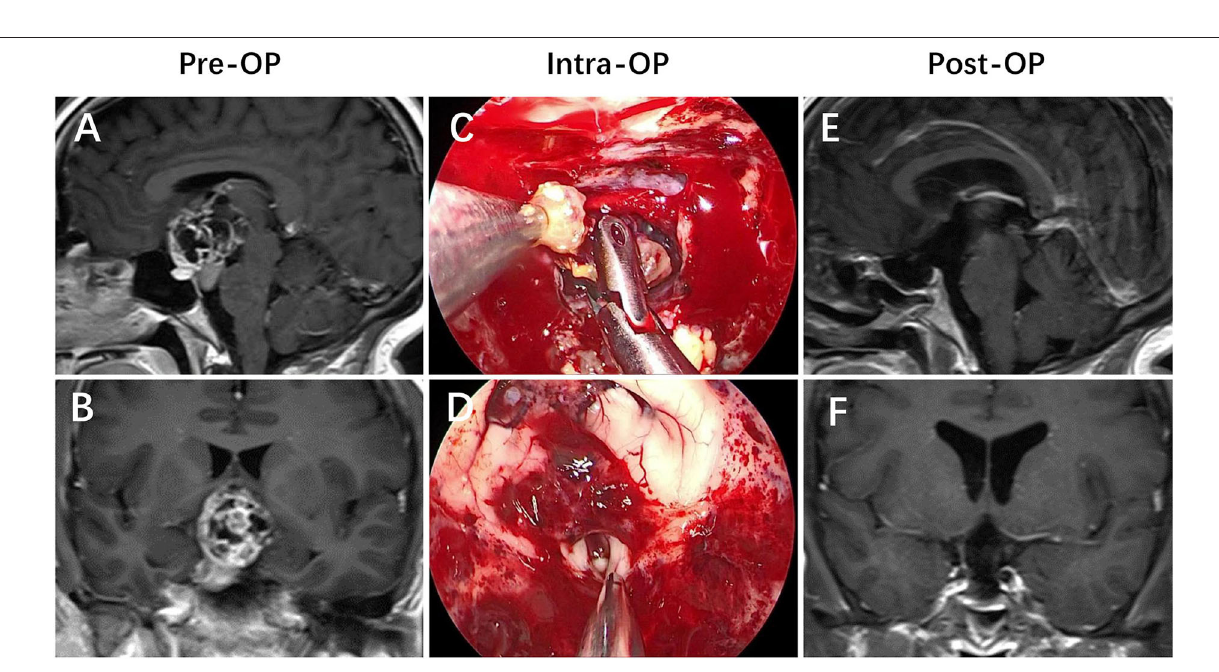
Frontiers in Neurology |